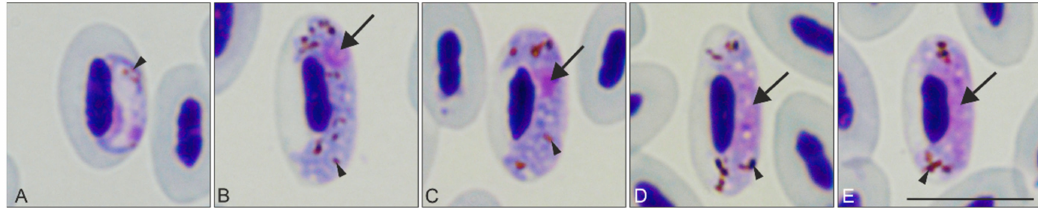
Figure 1. Gametocytes of Haemoproteus pastoris from naturally infected Common starlings Sturnus vulgaris . Young ( A ), growing ( B , D ), and mature ( C , E ) macrogametocytes ( B , C ) and microgametocytes ( D , E ) are shown. Note the presence of prominent pigment granules in gametocytes. The nuclei were compact and of sub-terminal position in macrogametocytes ( B , C ), but were diffuse and located centrally in microgametocytes ( D , E ). Ameboid extremities were visible in the growing gametocytes ( B , D ), and slight lateral displacement of the erythrocyte nuclei was seen in cells containing mature gametocytes ( C , E ). Triangle arrow ( )—parasite nucleus. Triangle arrowhead ( )—pigment granules. Images were taken using Giemsa-stained blood films at × 1000 magnification. Scale bar = 10 µ m.